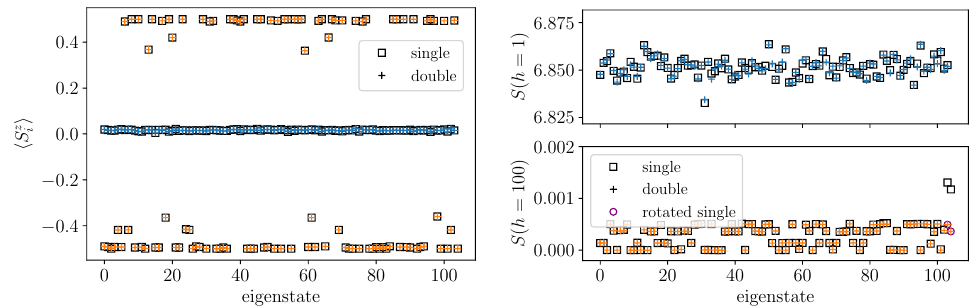
Figure 7: Comparison between quantities computed in single precision (squares) or double precision (crosses), as a function of the eigenstate label (eigenstates ordered by increasing energy), for a system of size L = 22, and for h = 1 (in blue), and 〉 of the spin i = L / 2, right panel: h = 100 (in yellow). Left panel: magnetization 〈 S z i entanglement entropy at the L / 2 cut. The “rotated single" label stands for entropies in single precision corrected by a rotation of the associated pair of eigenstates [ 45 ]